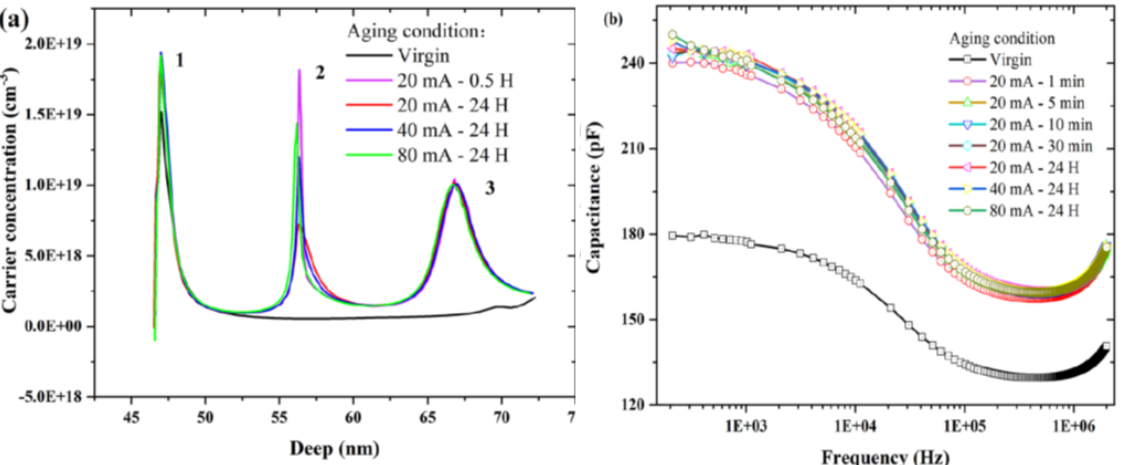
Figure 18. ( a ) ACD profiles of stressed and unstressed devices. ( b ) The capacitance vs. frequency diagram. Reproduced with permission. [73] Copyright 2021, AIP.